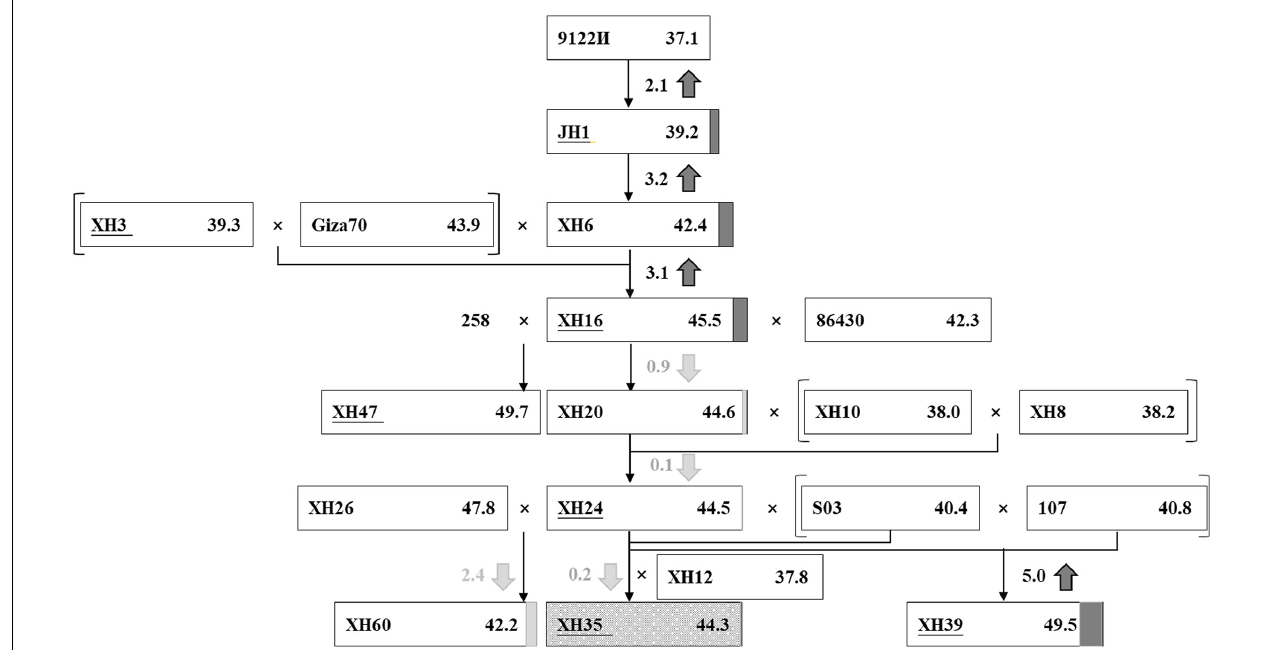
FIGURE 2 | The improvement of fiber strength in a selected pedigree. Each rectangle represents an accession. In the rectangle, the accession names are written on the left and the phenotype values of fiber strength (cN-tex − 1 ) are listed on the right. The different value of fiber strength between the current accession and the former parent is highlighted in the middle, with the up/down arrow showing the increase (in dark gray)/decrease (in light gray). The increment and decrement are also noted right behind the rectangle with dark gray box and light gray box, respectively. XH35, serving as the target cultivar of our research, is marked with dark gray snowflake